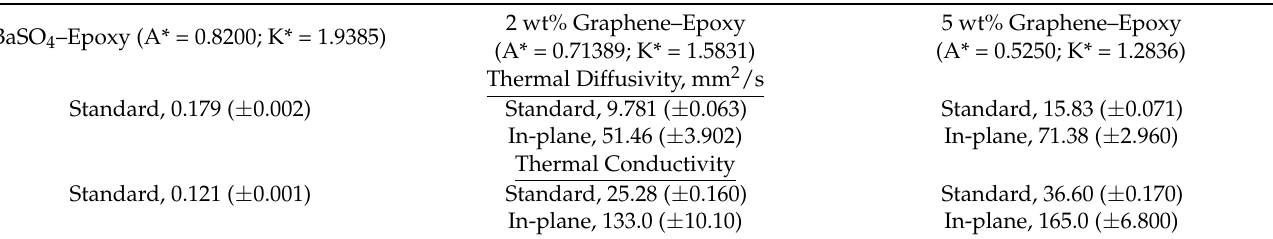
Table 2. Thermal properties of epoxy-based composites on 7205